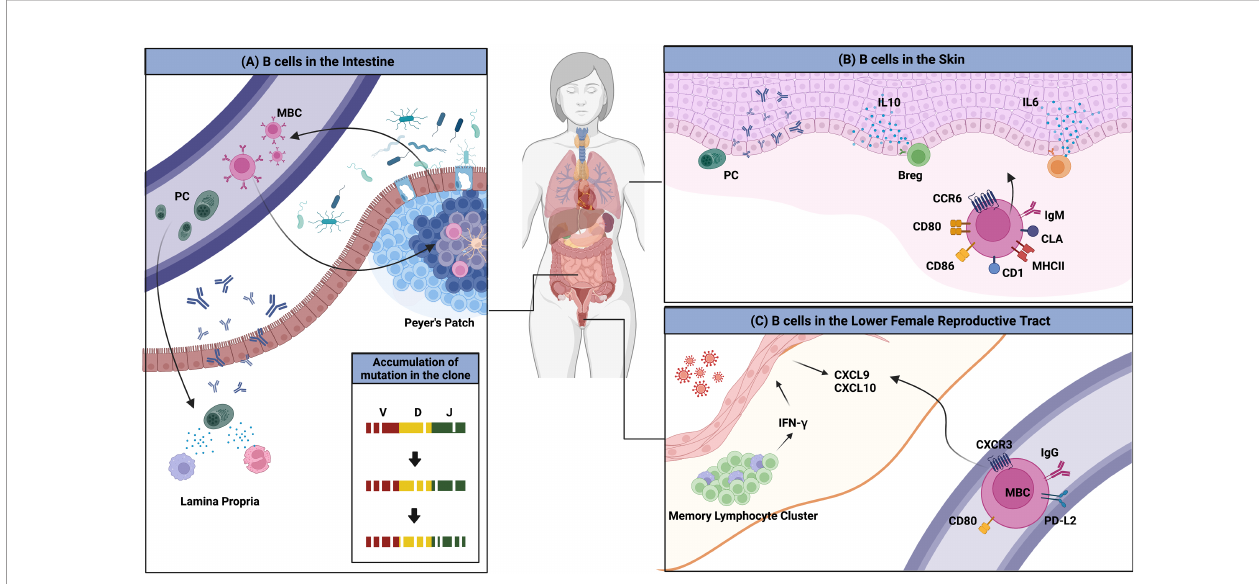
FIGURE 2 | Overview of B cells in multiple peripheral organs. (A) The gut microbiota is a consistent stimulus to immune cells in the gut. MBCs and PCs that are formed access the circulation and return to the gut; this migration is mediated by the chemokine receptors CCR9 and CCR10, and integrin a 4 b 7. PCs reside in the lamina propria and MBCs enter the GC reaction, which results in the evolution of BCR repertoires. (B) Several clues for the existence of skin-associated B cells are provided. B cells that migrate to the skin have higher expression of MHCII, CD1, CD86, CD80, and IgM. The migration to the organ is mediated by CCR6 and CLA. B cells in the skin produce antibodies locally and regulate the immune reaction directly by producing the pro-in fl ammatory cytokines such as IL-6 or the anti- in fl ammatory cytokine, IL-10. (C) BRMs are not established in the lower FRT. Upon secondary infection, circulating MBCs rapidly migrate to the tissues in a CXCR3- dependent manner. These cells show higher expression of MBC markers including PD-L2 and CD80. These cells could not stay long in the lower FRT